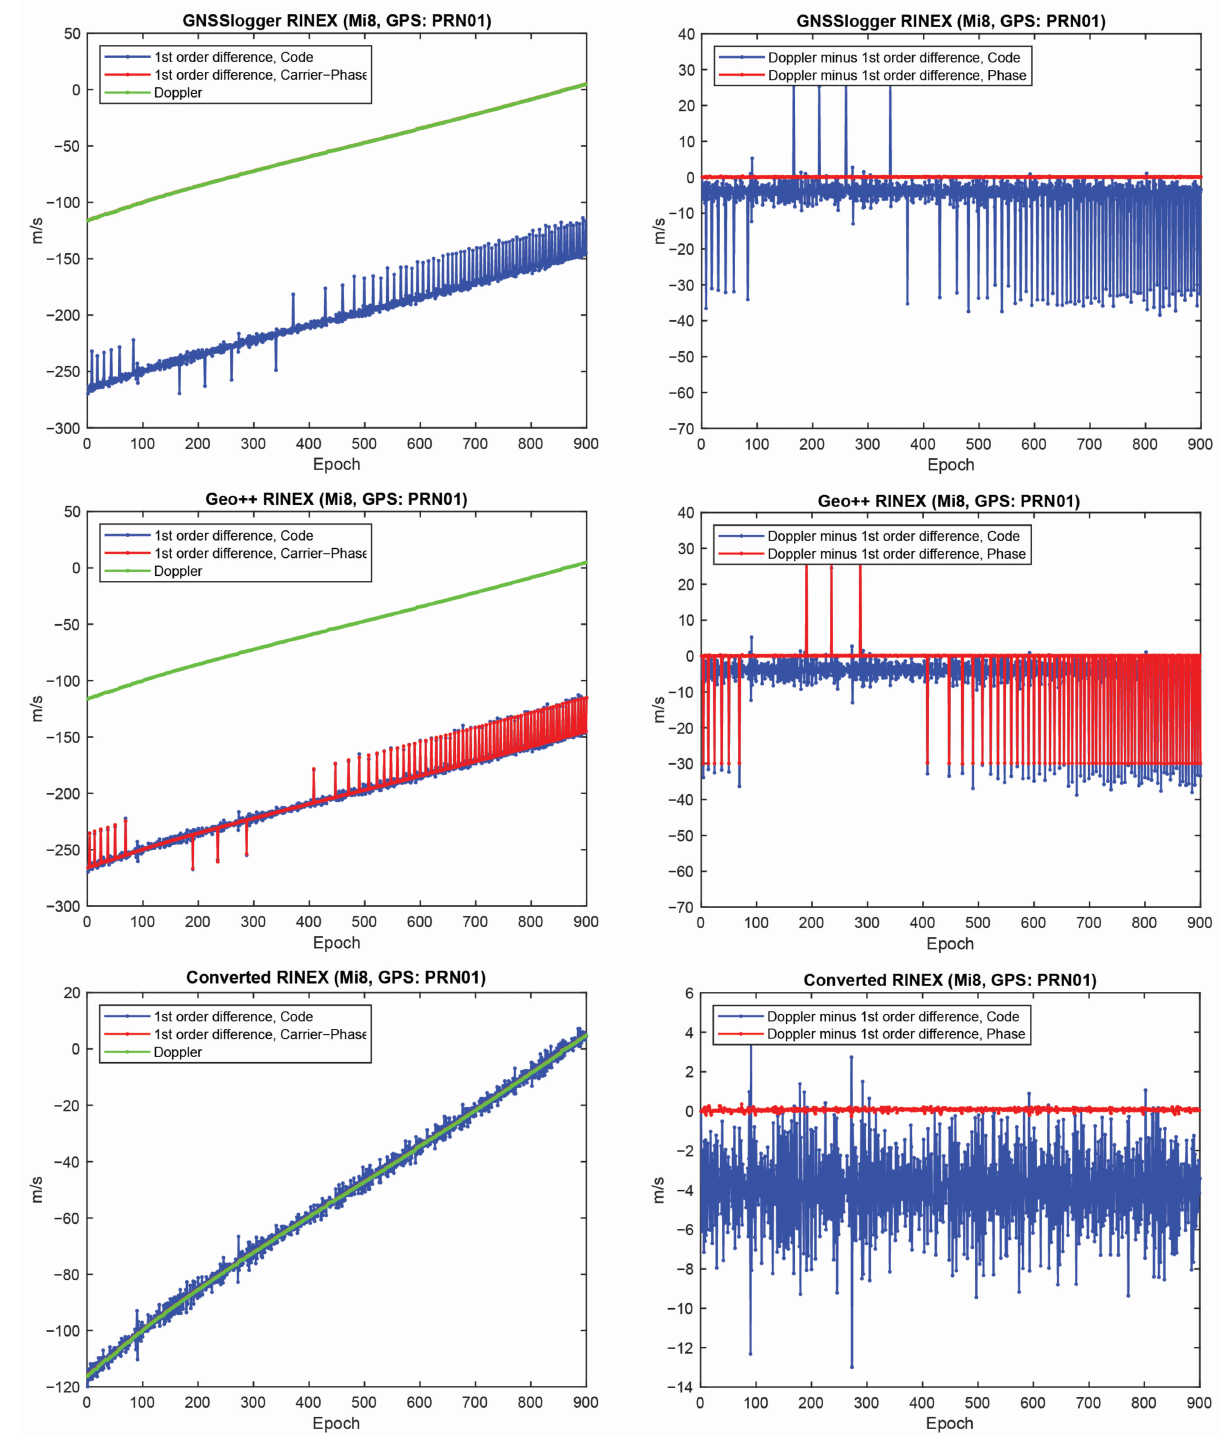
Figure 2. First-order differentiation of GPS pseudorange and carrier-phase observations as well as Doppler observations on L1 frequency for PRN 01 (Xiaomi